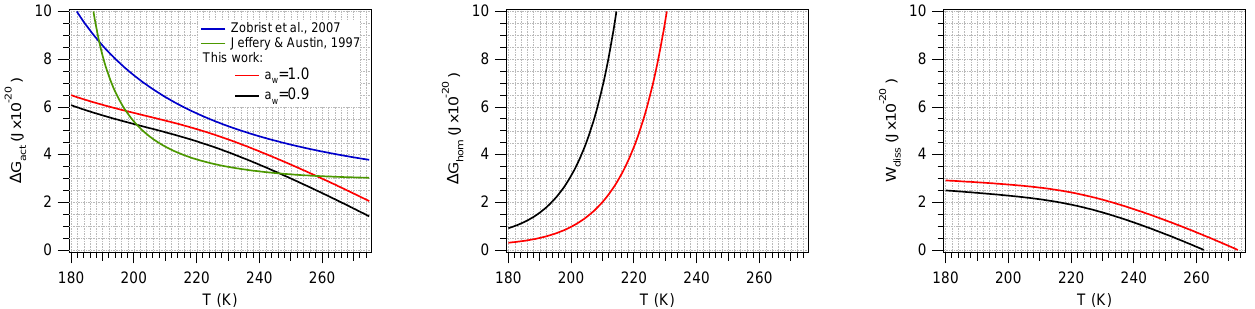
Figure 2. Activation energy (left panel), nucleation work (middle panel) and dissipated work (right panel). Black and red lines correspond to a w = 0 . 9 and a w = 1,